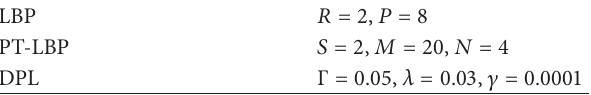
Table 2: Recognition rate with different degree of pose variation.